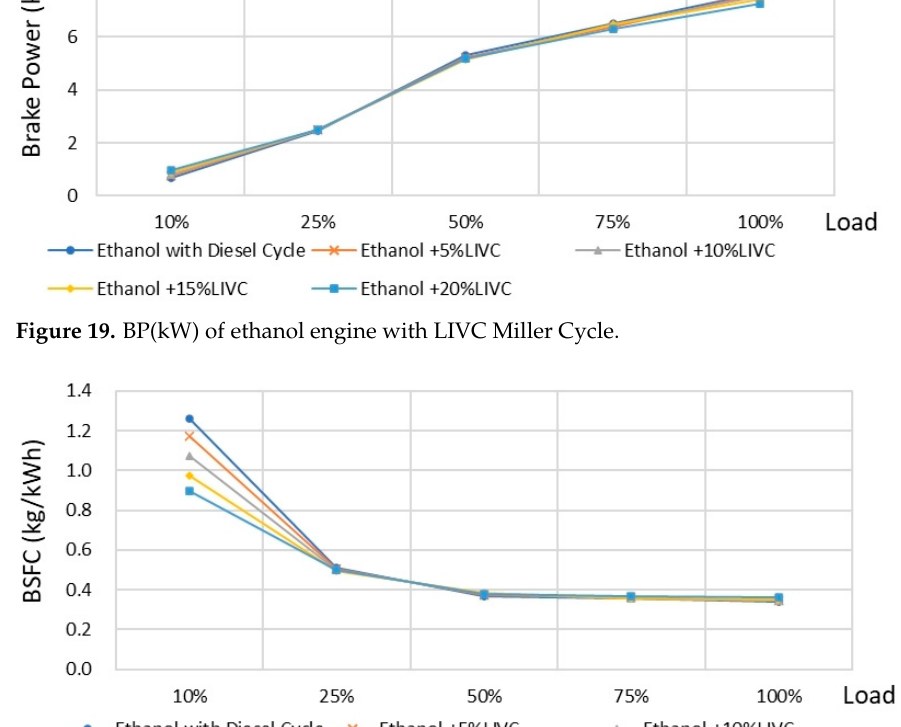
Figure 20. BSFC(g/kWh) of ethanol engine with LIVC Miller Cycle.